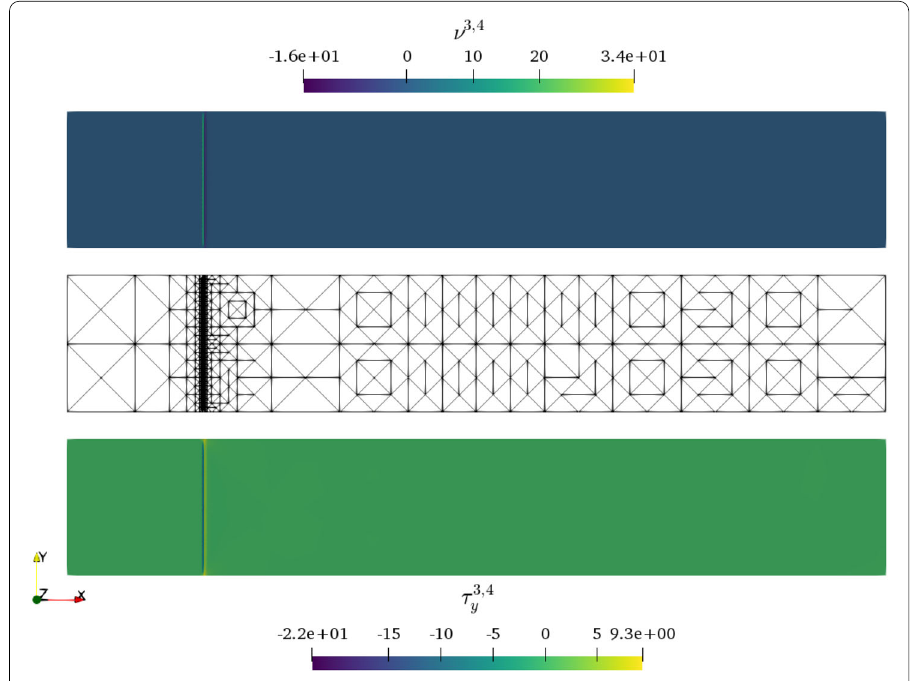
Fig. 14 Top: out-of-plane interface stress σ zz ( z = 0) = ν 3 , 4 . Middle: final adapted mesh. Bottom: interface shear stress σ yz ( z = 0) = τ 3 , 4